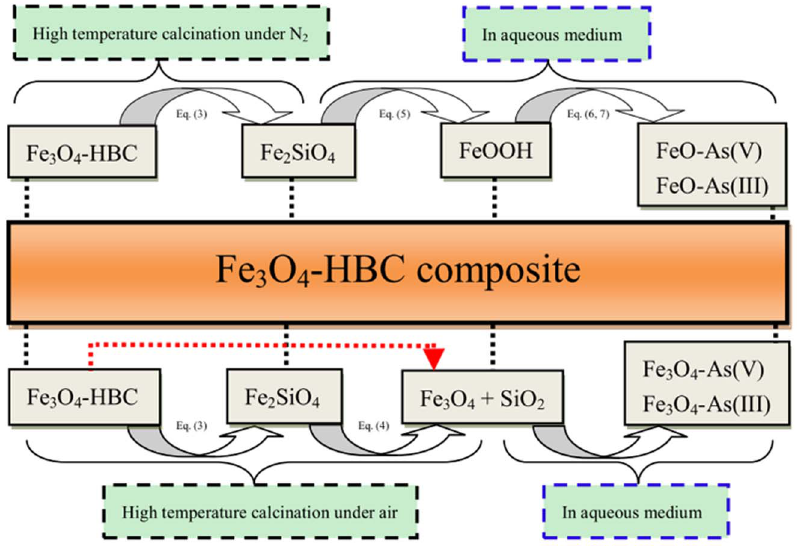
Figure 8. The proposed removal mechanism for As(V) and As(III) in aqueous system.